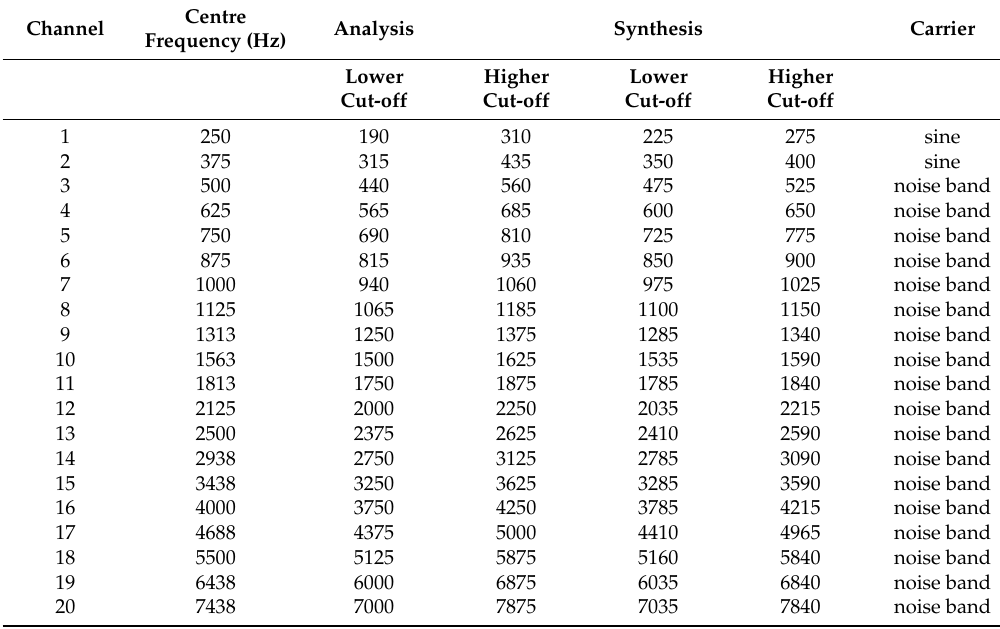
Table 1. Centre and cut-off frequencies of the vocoder